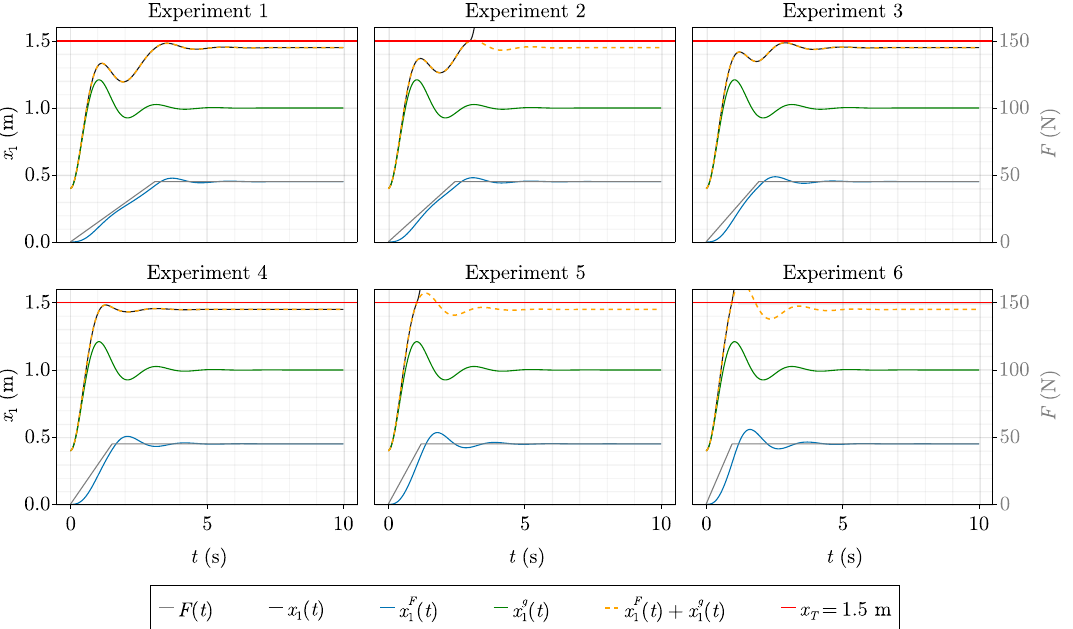
Figure 3. Superposed positions of the experiments in the violet rectangle of Fig. 2. Whenever the superposed g x F position yields a position x 1 + 1 that is larger than the snapping displacement x 1 ( t ) displays